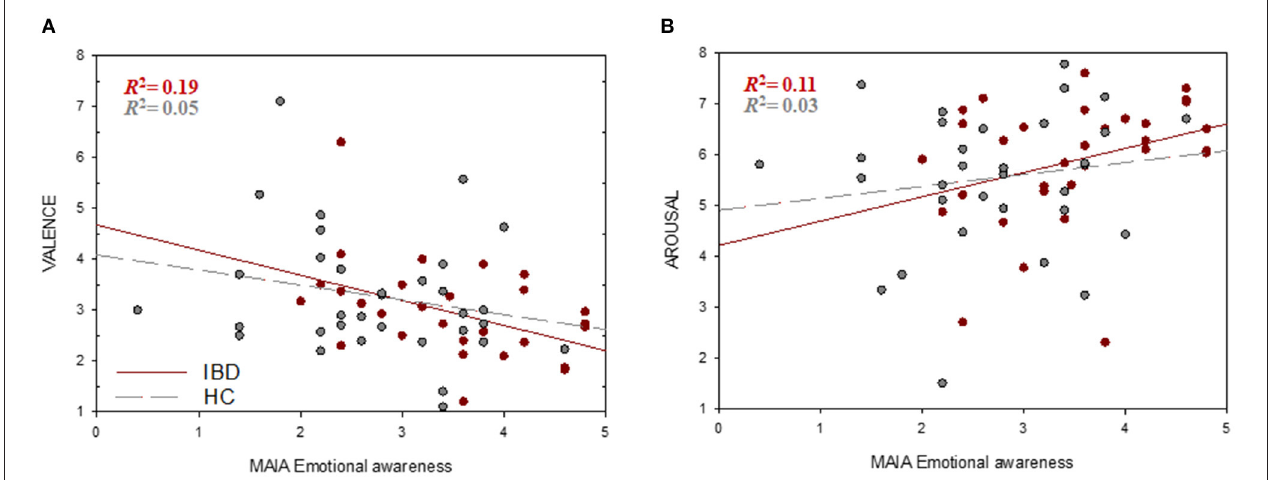
FIGURE 3 | Associations between interoceptive sensibility and emotional processing. Higher IS emotional awareness (MAIA) scores were associated with higher higher negative valence (1 = very unpleasant, 8 = very pleasant) (A) and arousal ratings (1 = low arousal, 8 = high arousal). (B) of negative